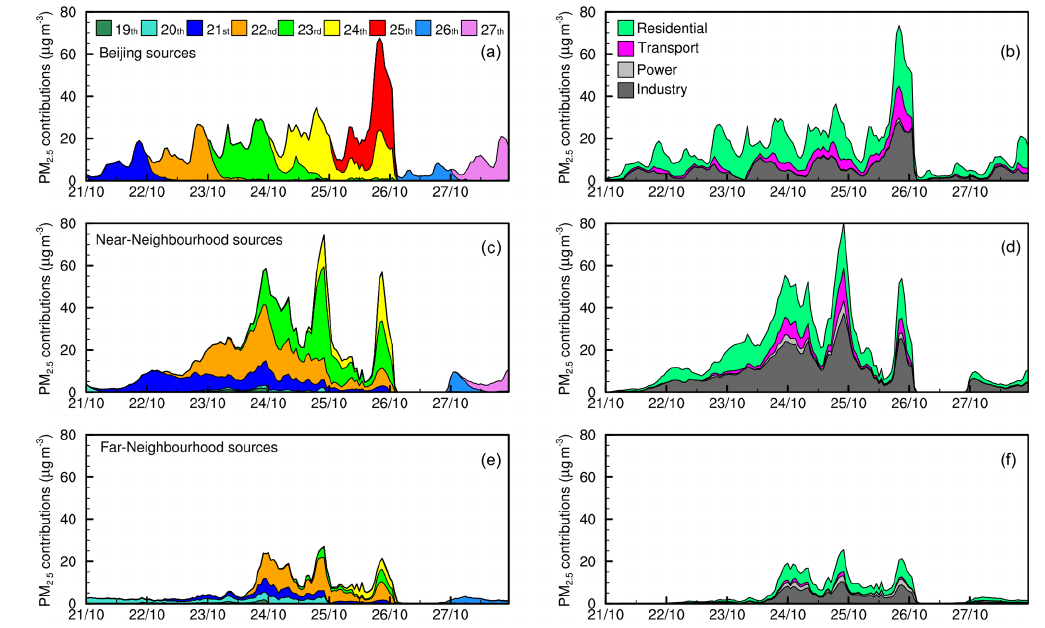
Figure 9. Contributions of 1d emission controls (a, c, e) and continuous sectoral controls (b, d, f) to PM 2 . 5 in Beijing showing how PM 2 . 5 can be attributed to the day, region, and sector of emissions. Contributions from each sector (derived at 100%) were scaled down to match the 30%–50% reductions used for the 1d